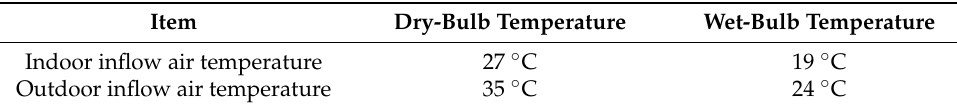
Table 11. Cooling test conditions in standard climate.